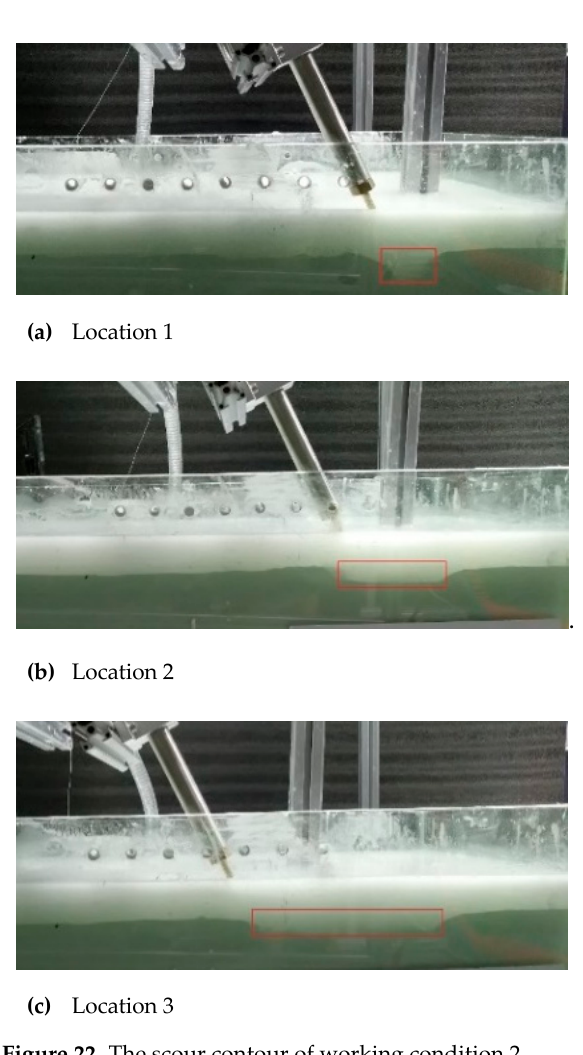
Figure 22. The scour contour of working condition 2.